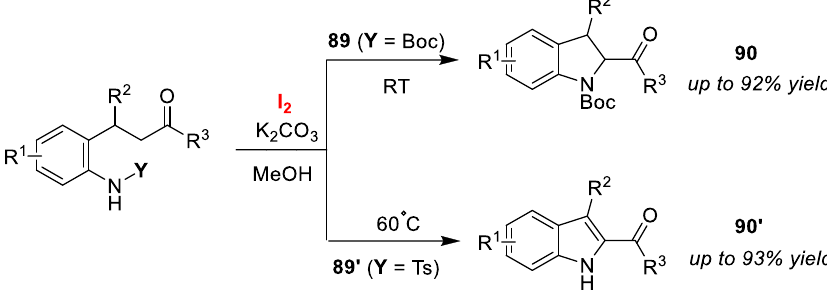
Figure 42. Selective syntheses of 2-acylindolines 90 and 2-acylindoles 9 0′ via the N -protection- dependent cyclization of O -acylethyl N -subsituted anilines ( 89 and 8 9′ ) using an I 2 /K 2 CO 3 system.